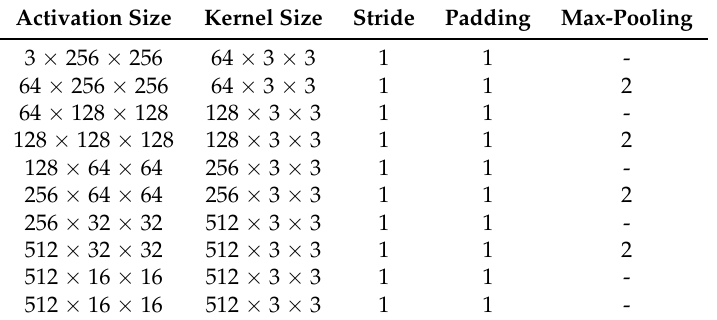
Table 1. The detailed information of encoder. The encoder part performs maximum pooling every two convolutions, and convolved twice after four times of pooling.